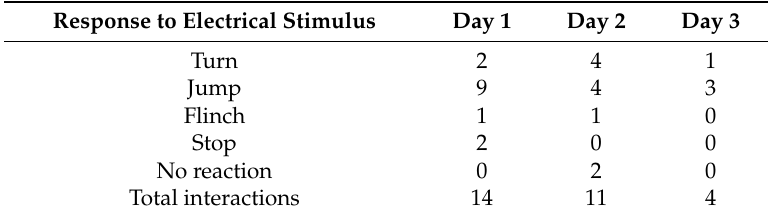
Table 4. Count of behaviours from six sheep, displayed in response to the electrical stimulus over the three days the virtual fence was